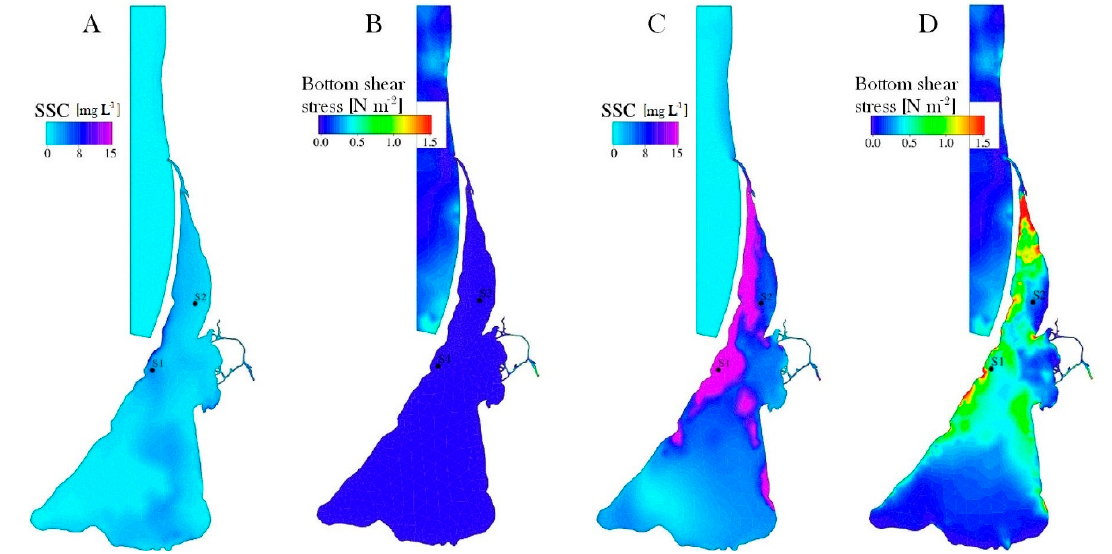
Figure 10. One-day (1 February 2014) event of the influence of ice cover on the sediment transport simulation (wind speed 10 m s − 1 , SE direction). ( A ) SSC with ice; ( B ) bottom shear stress with ice; ( C ) SSC without ice; ( D ) bottom shear stress without ice.